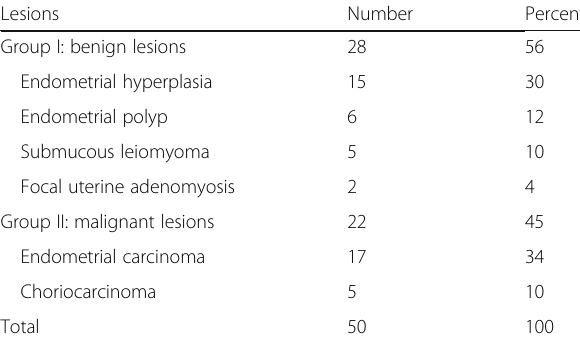
Table 1 Histopathological results of all studied lesions ( n = 50) Lesions